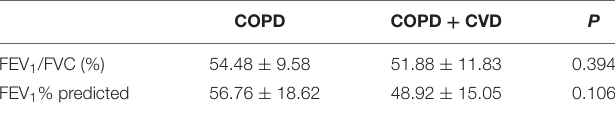
TABLE 3 | Lung function between two groups.